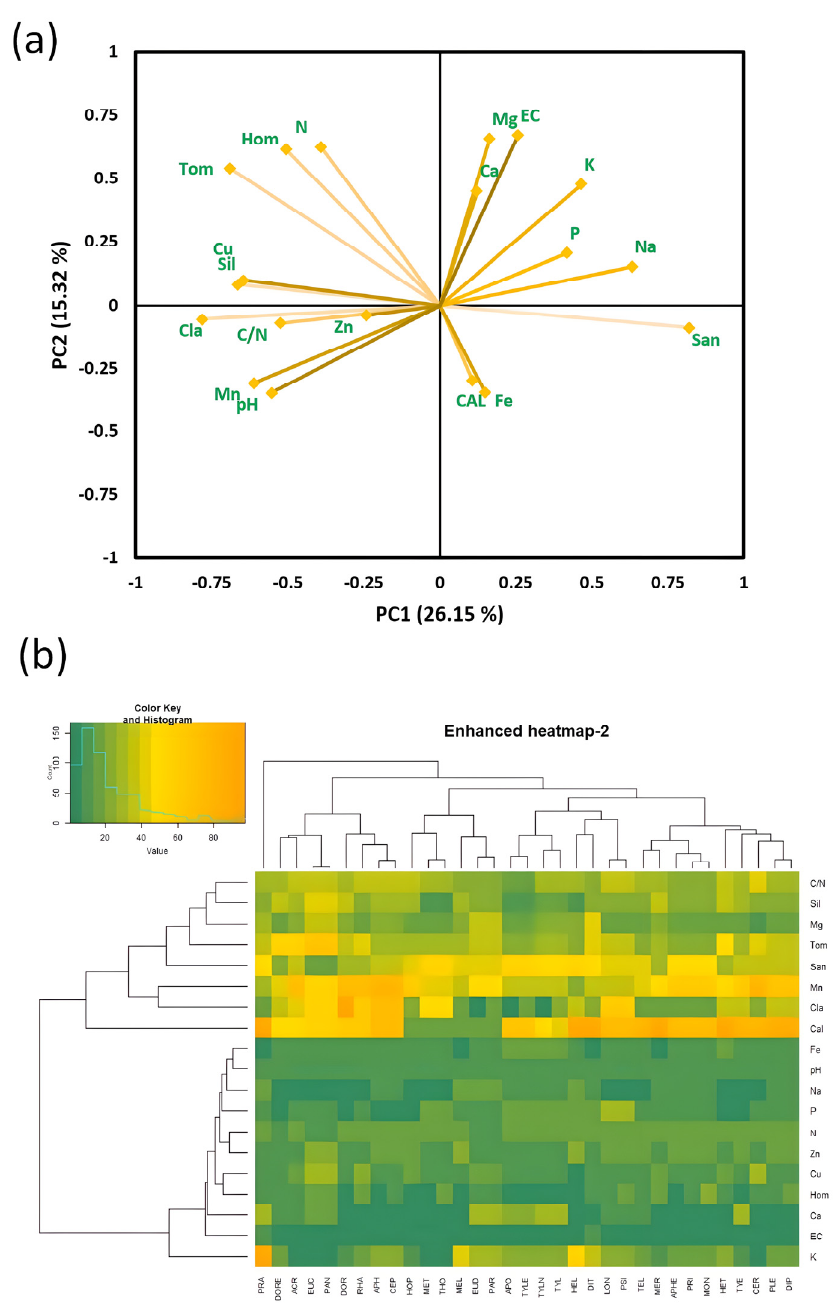
Figure 6. Physical-chemical soil patterns and correlation with nematode assemblies. ( a ) PCA loading plot for soil characteristics. ( b ) Advanced heatmap (enhanced heatmap-2) showing the population structure of nematode taxa in relationship with soil parameters. Ward’s clustering algorithm was applied to the Spearman dissimilarity matrix of nematode distribution in wheat fields in interaction with physical-chemical soil characteristics. The upper dendrogram represents nematode patterns. The left dendrogram represents soil patterns. The color key scale represents the normalized Row Z-score of nematode abundance (per 100 cm 3 of soil).